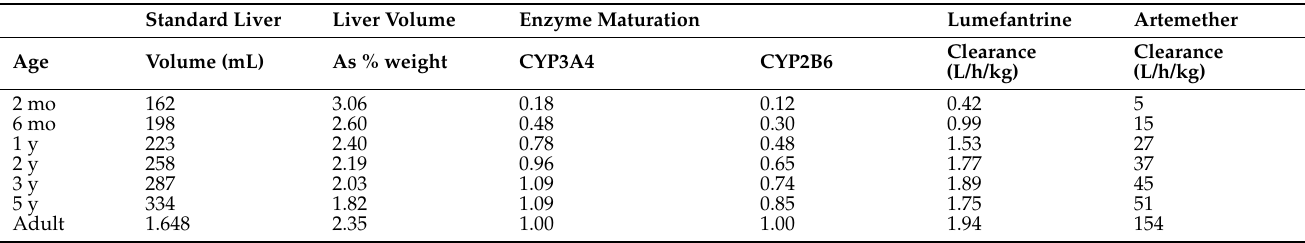
Table 3. Theoretical calculation of clearance for lumefantrine and artemether based on liver enzyme maturation in children, using the elimination rate constant in adults as a reference